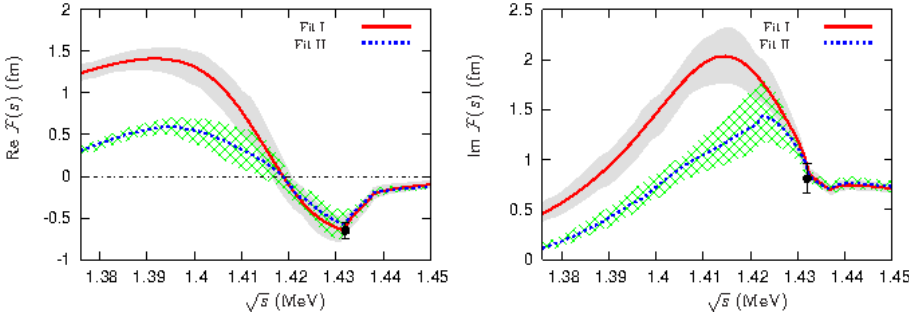
Figure 1. Real (left panel) and imaginary (right panel) parts of the K − p center-of-mass (cm) scattering amplitudes generated in two NLO chiral-model fits [5]. The K − p threshold values marked by solid dots follow from the SIDDHARTA measurement of kaonic hydrogen 1 s level shift and width [6]. Figure adapted from Ref.